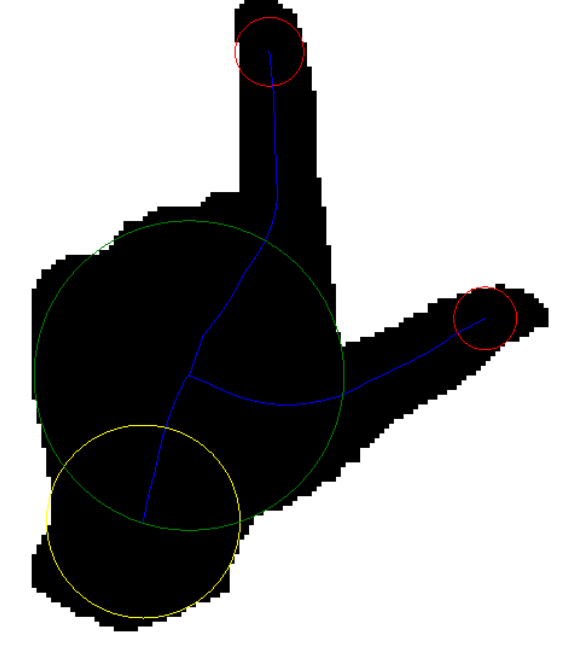
Figure 6: Terminal branches